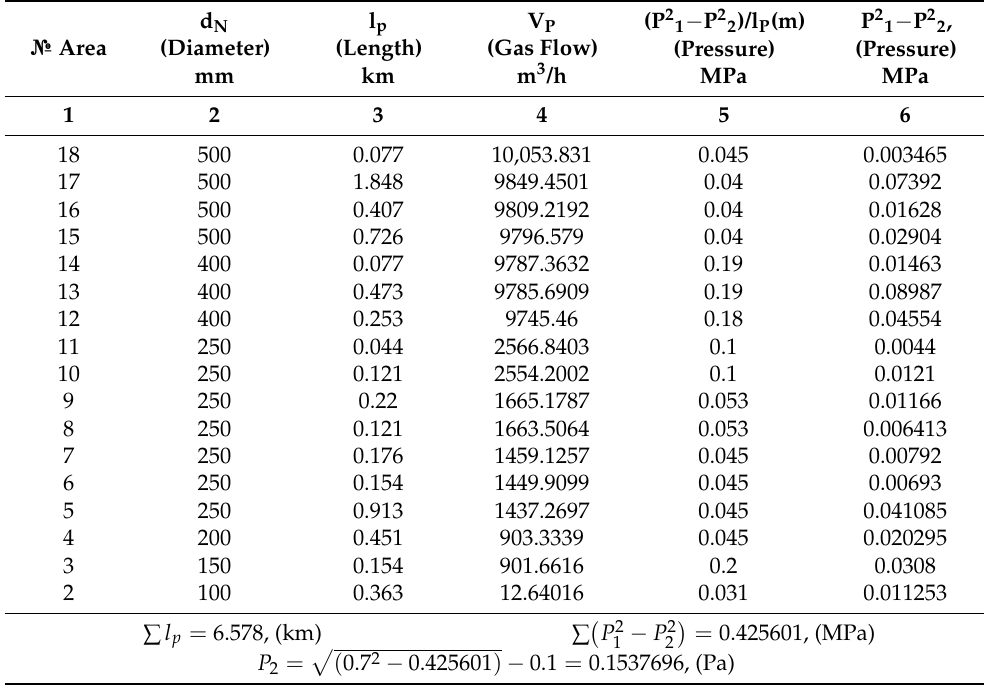
Table 4. Emergency mode at area 1 (Refusal at area 1).